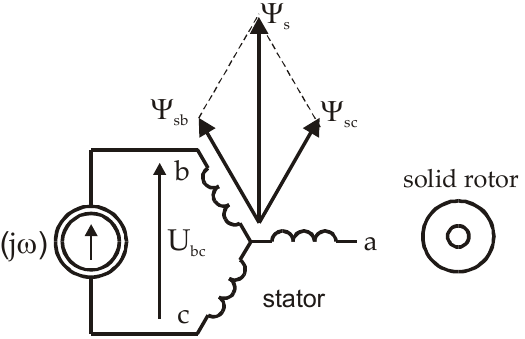
Figure 4. Connection scheme for the SFFR test.